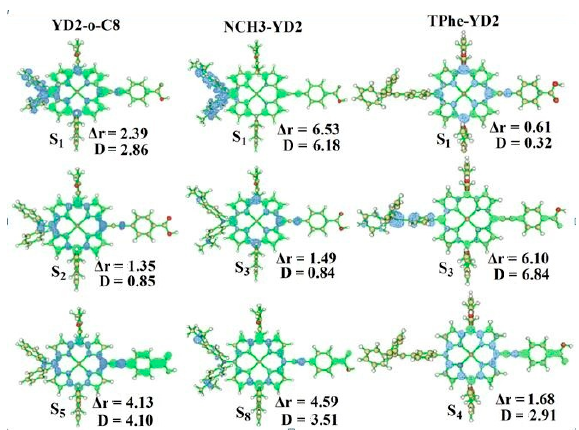
Figure 6. The hole and electron distributions for the studied dyes. The blue and green isosurfaces represent hole and electron distributions, respectively.